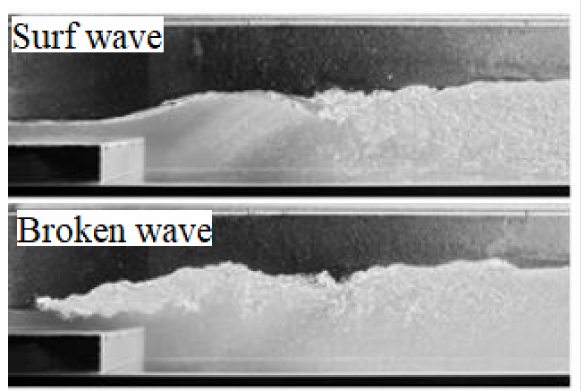
Figure 3. Transition from surf wave to broken wave (conventional hydraulic jump) by tailwater manipulation—photo courtesy of Wyl [33].